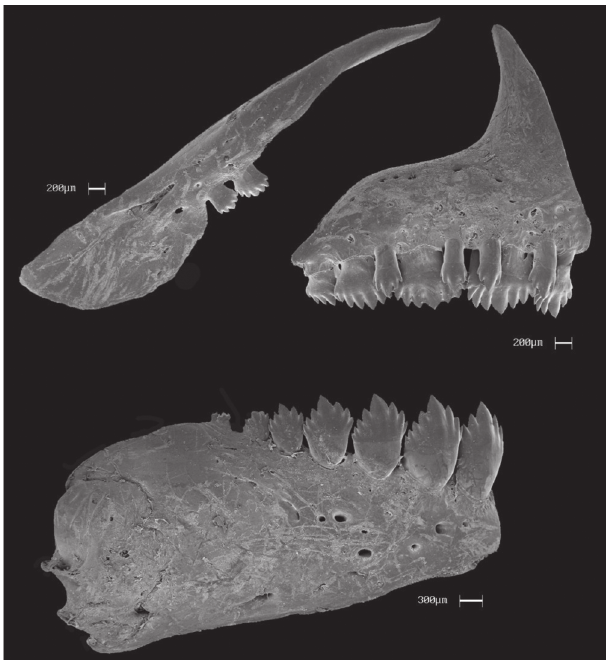
Fig. 3. Jupiaba kurua , paratype, MZUSP 96857, 77.6 mm SL. Scanning eletronic microscopy of left side of upper and lower jaws (figure re-oriented). dorsal and ventral borders of caudal peduncle; some specimens with caudal peduncle blotch, extending as a faded stripe onto median caudal-fin rays. Dark chromatophores concentrated along lateral margins of caudal-fin rays. Dorsal fin with scattered dark pigmentation. Anal fin darkened in similar pattern as dorsal fin, but with chromatophores more concentrated along its distal border, forming inconspicuous dark band. Pectoral and pelvic fins of rays. Adipose fin with scattered dark chromatophores. Color in life. Body and head tending to pale below lateral midline, tan and darker dorsally. Dorsal and adipose fins somewhat orange, pectoral, pelvic, anal, and caudal fins yellow. Anal fin with dark distal band. Eyes black, except for red anterodorsal portion.